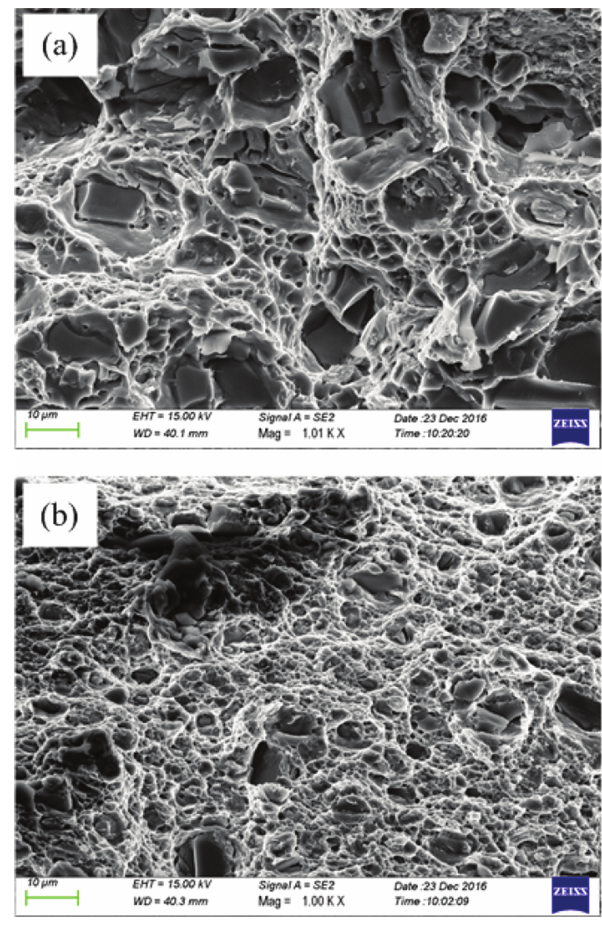
Figure 9: Fracture morphologies of (a) air cooling specimen and (b) water cooling